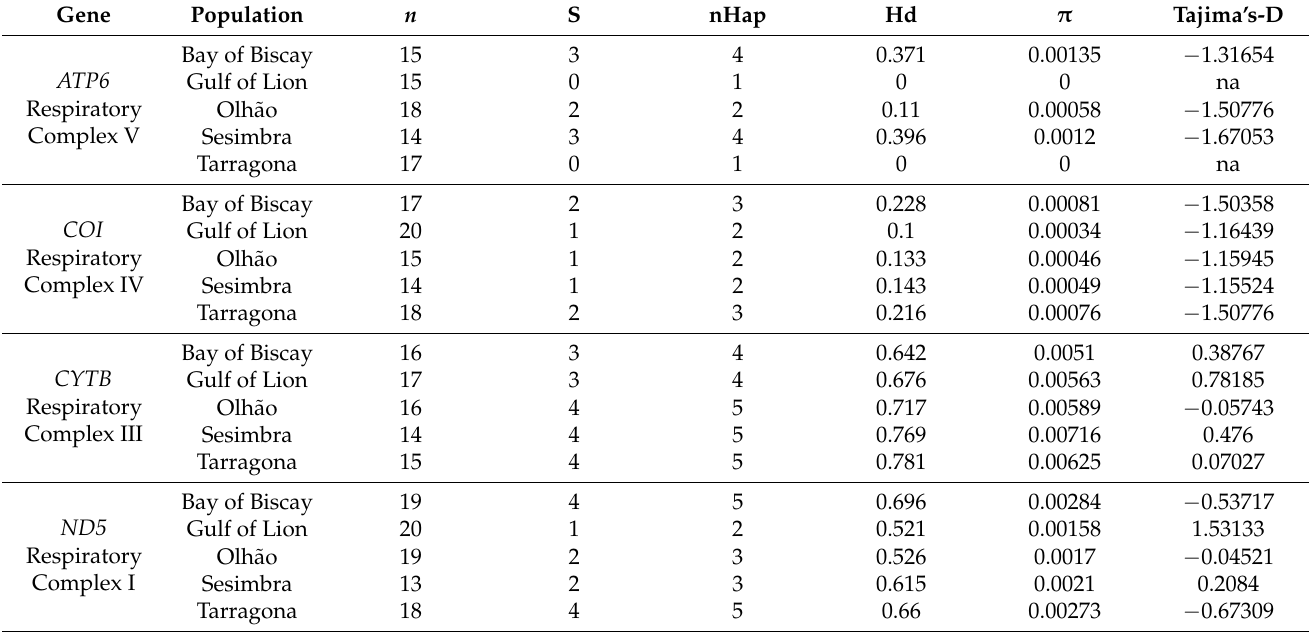
Table 1. Diversity estimates obtained for each mitochondrial gene region coding and respective complex of the electron transport